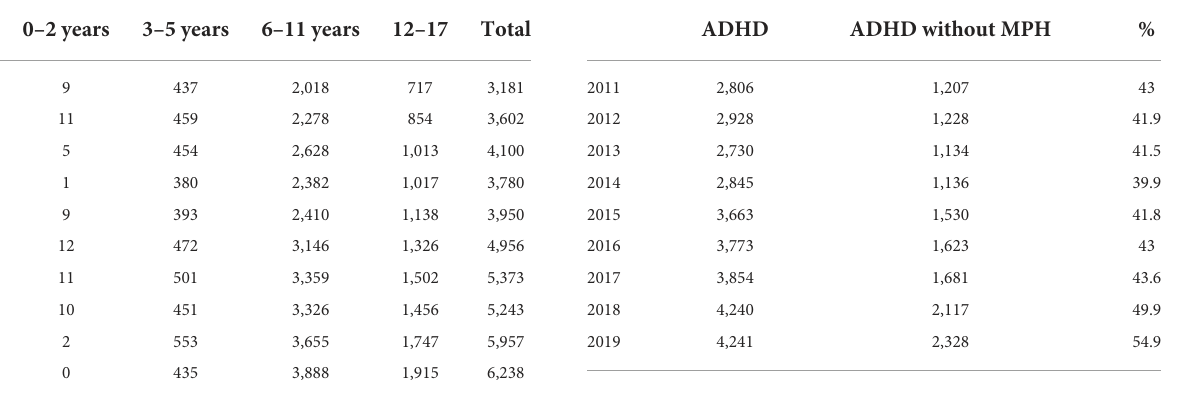
TABLE 1 Trends in the number of patients coded as ADHD in health databases by age-group and year.